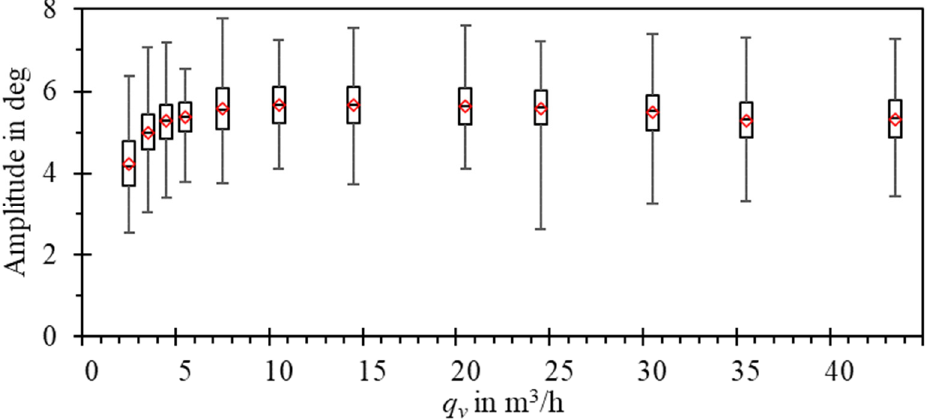
Figure 19. Box-whiskers plot of the amplitude of oscillations vs. flow rate, measured experimentally at the water calibration stand.